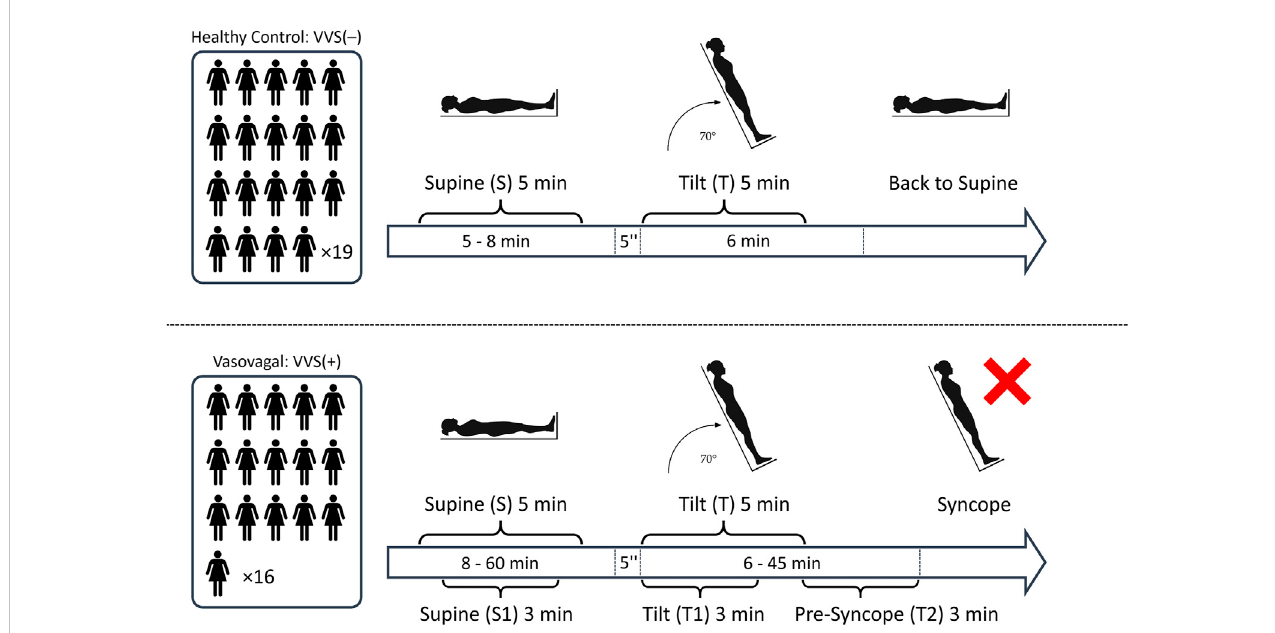
FIGURE 1 Theschematicillustrationofthestudyprotocol:Thenumberofparticipantsineachstudygroupandthesegmentsofbiosignalsfromthetilttest:S,5 min supine; T, initial 5 min of tilt; S1, 3 min supine; T1, initial 3 min of tilt; and T2, pre-syncope phase (the last 3 min before the onset of syncope symptoms).